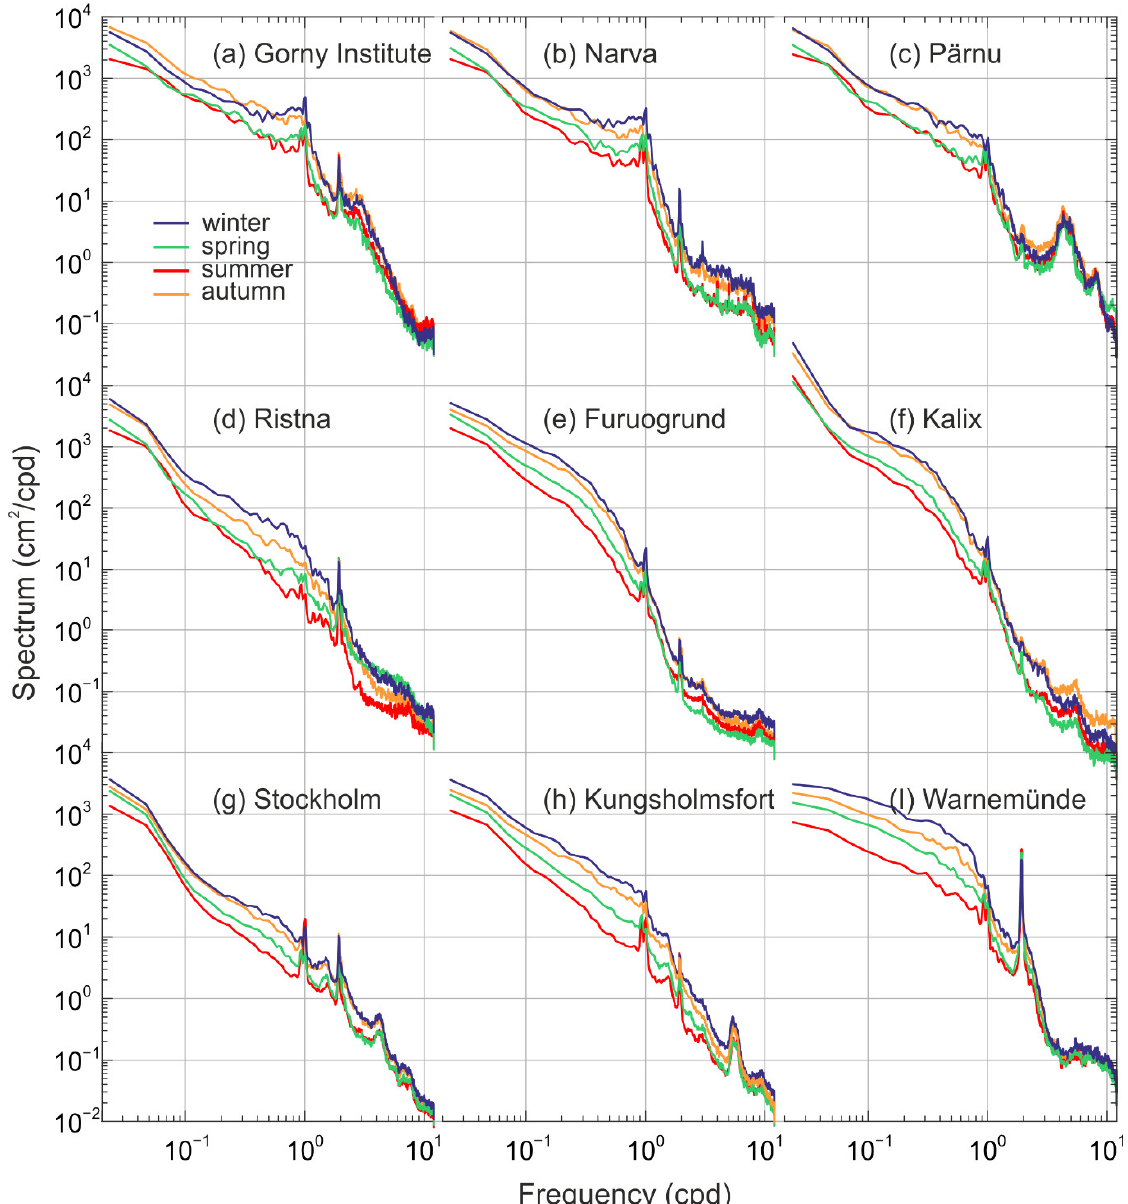
Figure 2. Seasonal spectra of the sea level oscillations at nine Baltic Sea stations: ( a ) Gorny Institute, ( b ) Narva, ( c ) Pärnu, ( d ) Ristna, ( e ) Furuogrund, ( f ) Kalix, ( g ) Stockholm, ( h ) Kungsholmsfort, ( i ) Warnemünde.